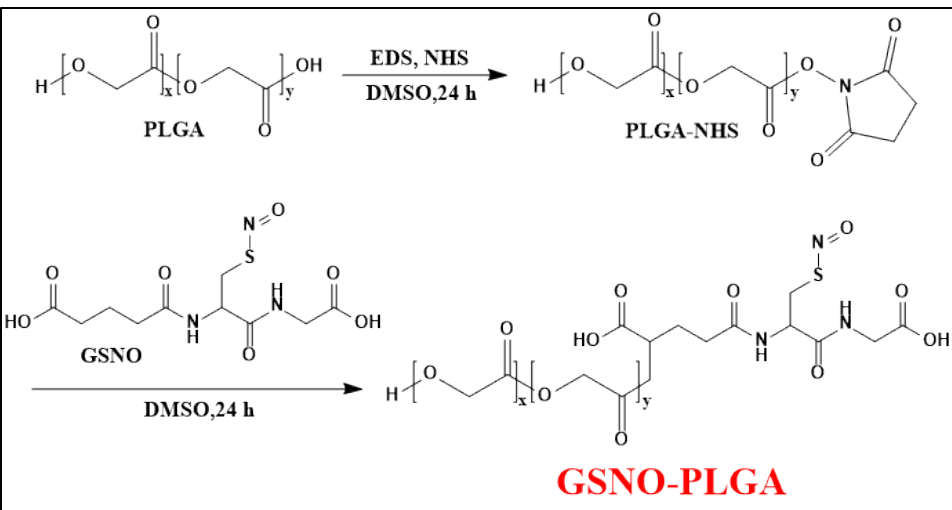
Figure 8. Synthesis scheme of GSNO-conjugated poly (lactic-co-glycolic acid) (GSNO-PLGA) [69].